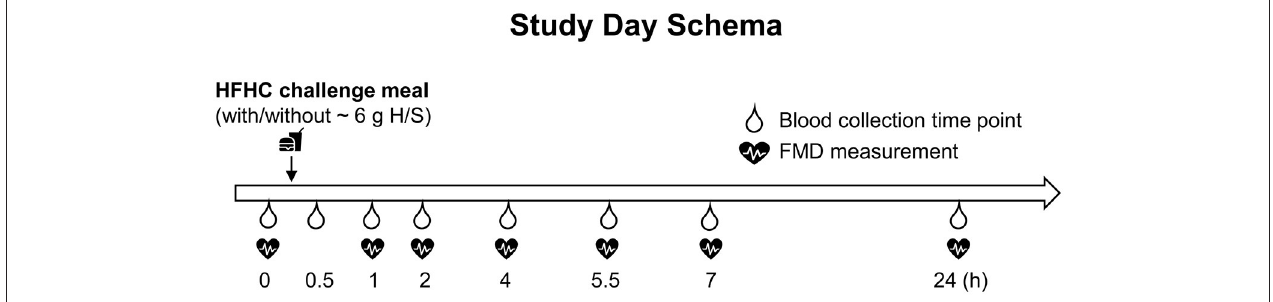
FIGURE 1 | Seven hours of postprandial and 24h follow up study visit schema. FMD, flow-mediated dilation; HFHC, high-fat and high-carbohydrate; H/S, herbs and